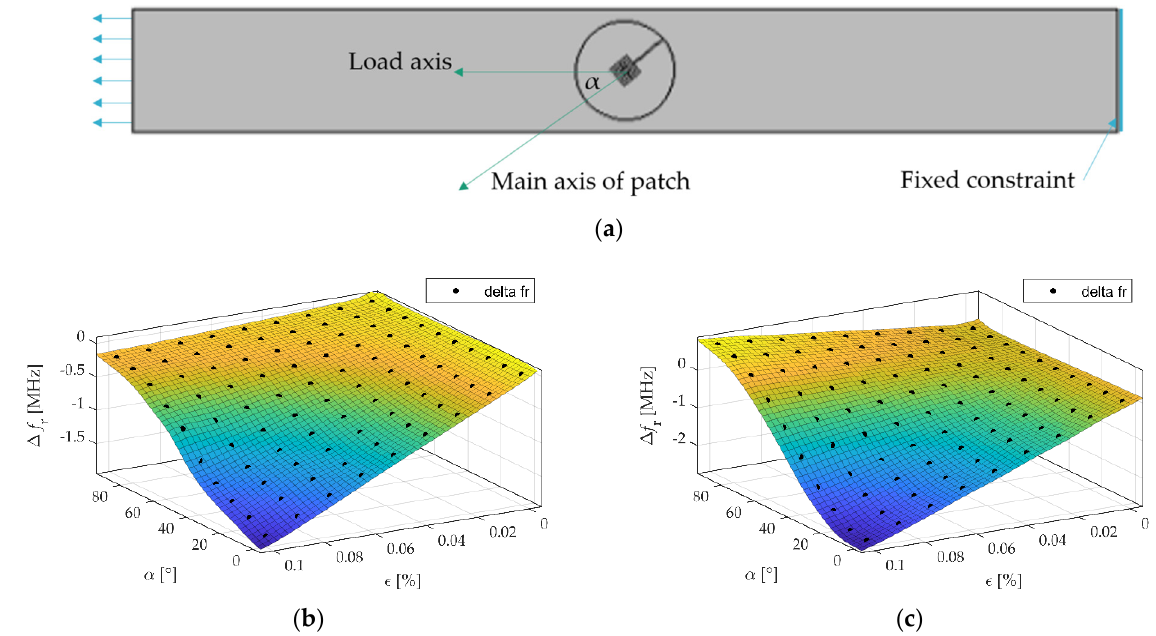
Figure 7. Directional characteristics of Δ f r for different strain levels ( a ) top view of the considered sample and definition of applied strain direction angle α ; ( b ) dSRR microstrip sensor; ( c ) rectangular microstrip sensor. Table 1. Comparison of the studied sensors.